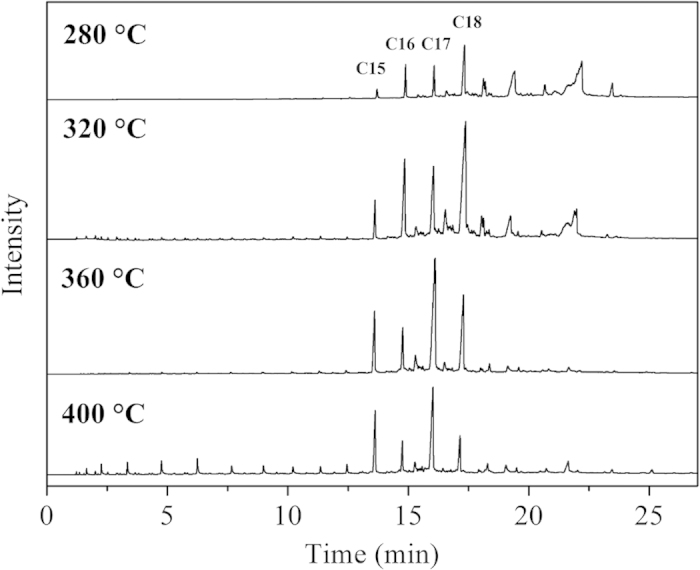
GC charts of product oil from hydroprocessing of Jatropha oil over synthetic Ni-PTA(10)/Al2O3 catalyst at 280–400 °C, 3.0 MPa, 0.8 h−1.